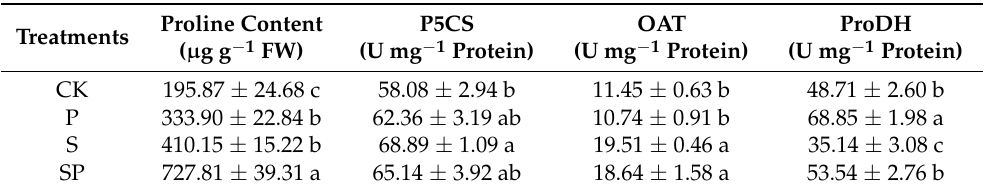
Table 3. Effects of proline (30 mM) treatment on proline content, P5CS activity, OAT activity, and ProDH activity of alfalfa under salt stress.